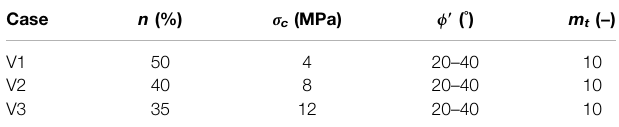
TABLE 2 | Strength properties of the